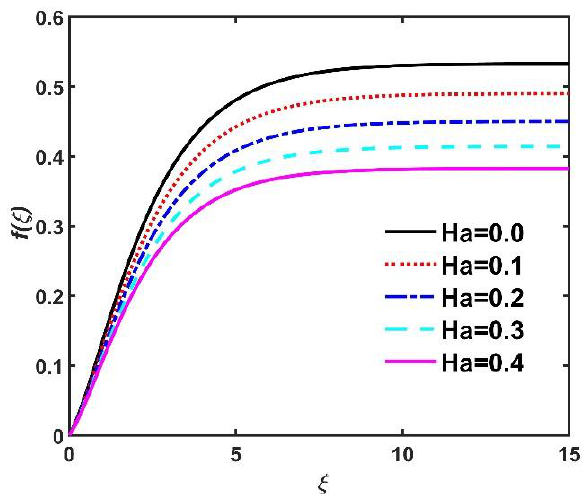
Figure 12. Impact of 𝐻𝑎 on 𝑓(𝜉) .